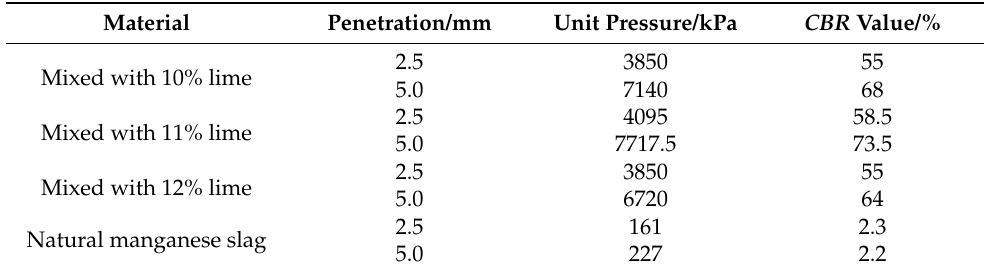
Table 6. CBR value of manganese slag with different lime content.